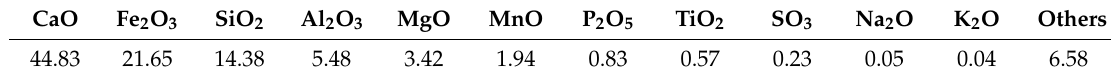
Table 1. Chemical composition of metallurgical steel slag (wt.%).